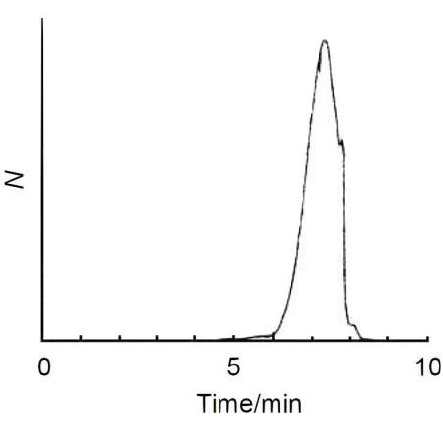
Figure 1. GPC curve of